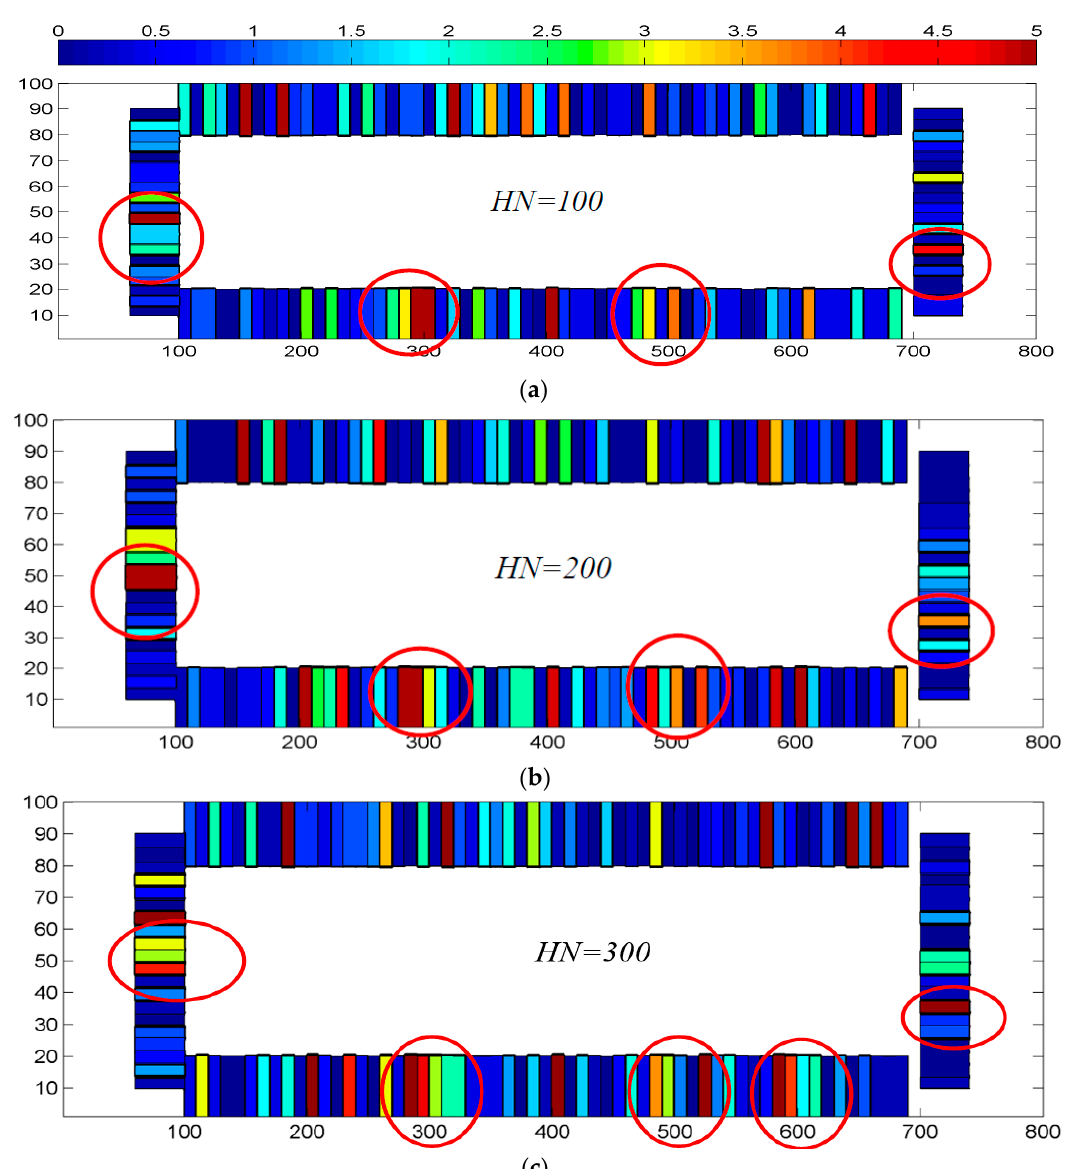
Figure 12. Accuracy of localization by using neural networks for different number of neurons in the hidden layer. ( a ) HN = 100; ( b ) HN = 200; ( c ) HN = 300.